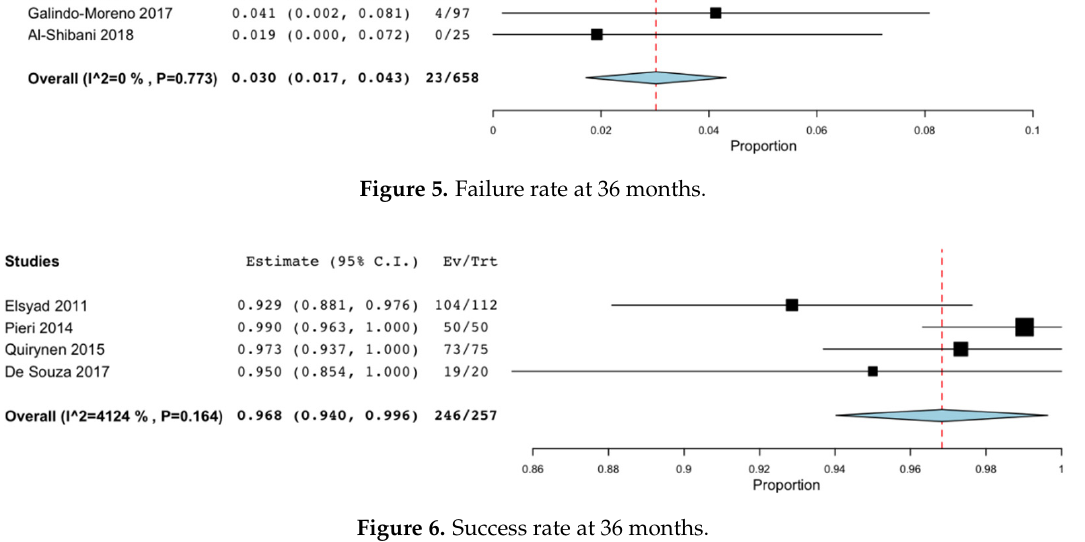
Figure 6. Success rate at 36 months.